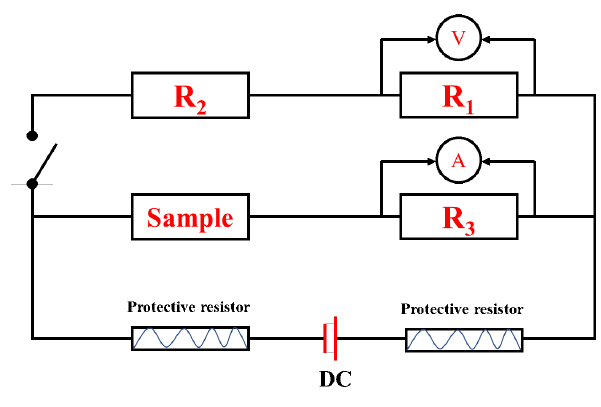
Figure 1: Schematic diagram of circuit used for electrical degrada-